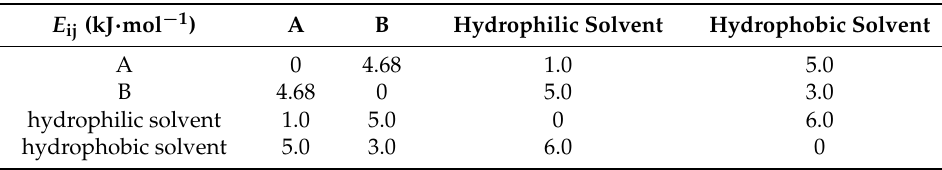
Table 1. Input parameters ( E ij )